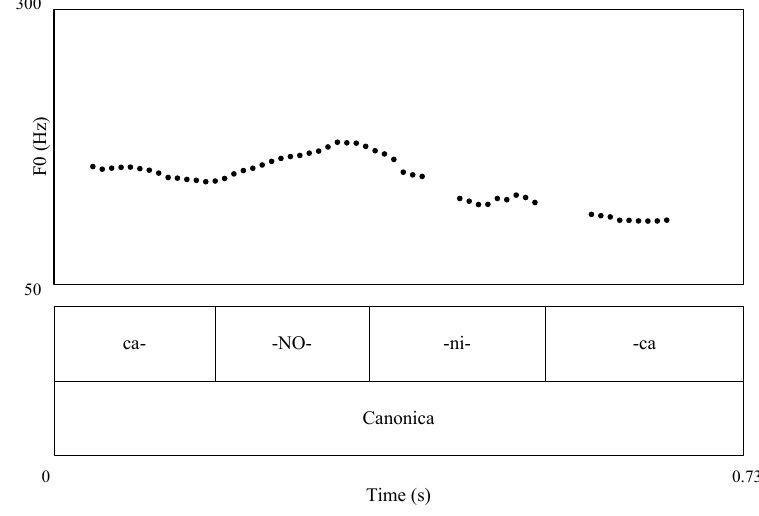
Figure 8. Rising-falling contour for seeking confirmation (‘Canonica?’), produced by Diego in Extract (12). This rising-falling contour is a main interrogative contour in the variety of Italian represented in my data — Trentino Italian (cf. Grice et al. 2005; Savino 2012 on the same contour used in other varieties). In the